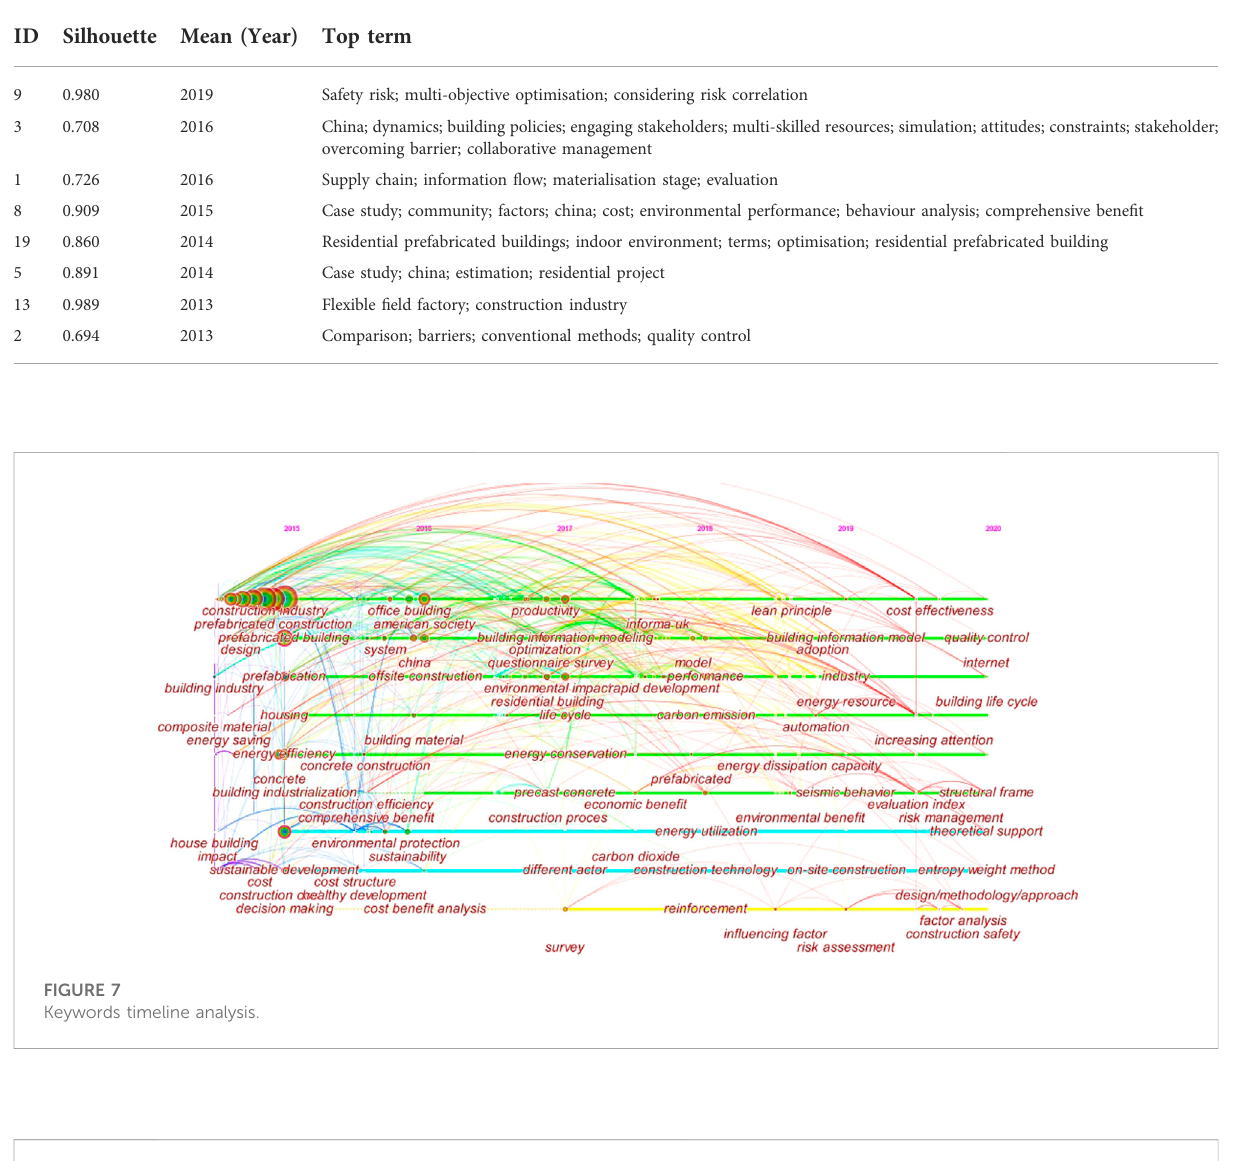
TABLE 5 Top term of Keywords cluster analysis.